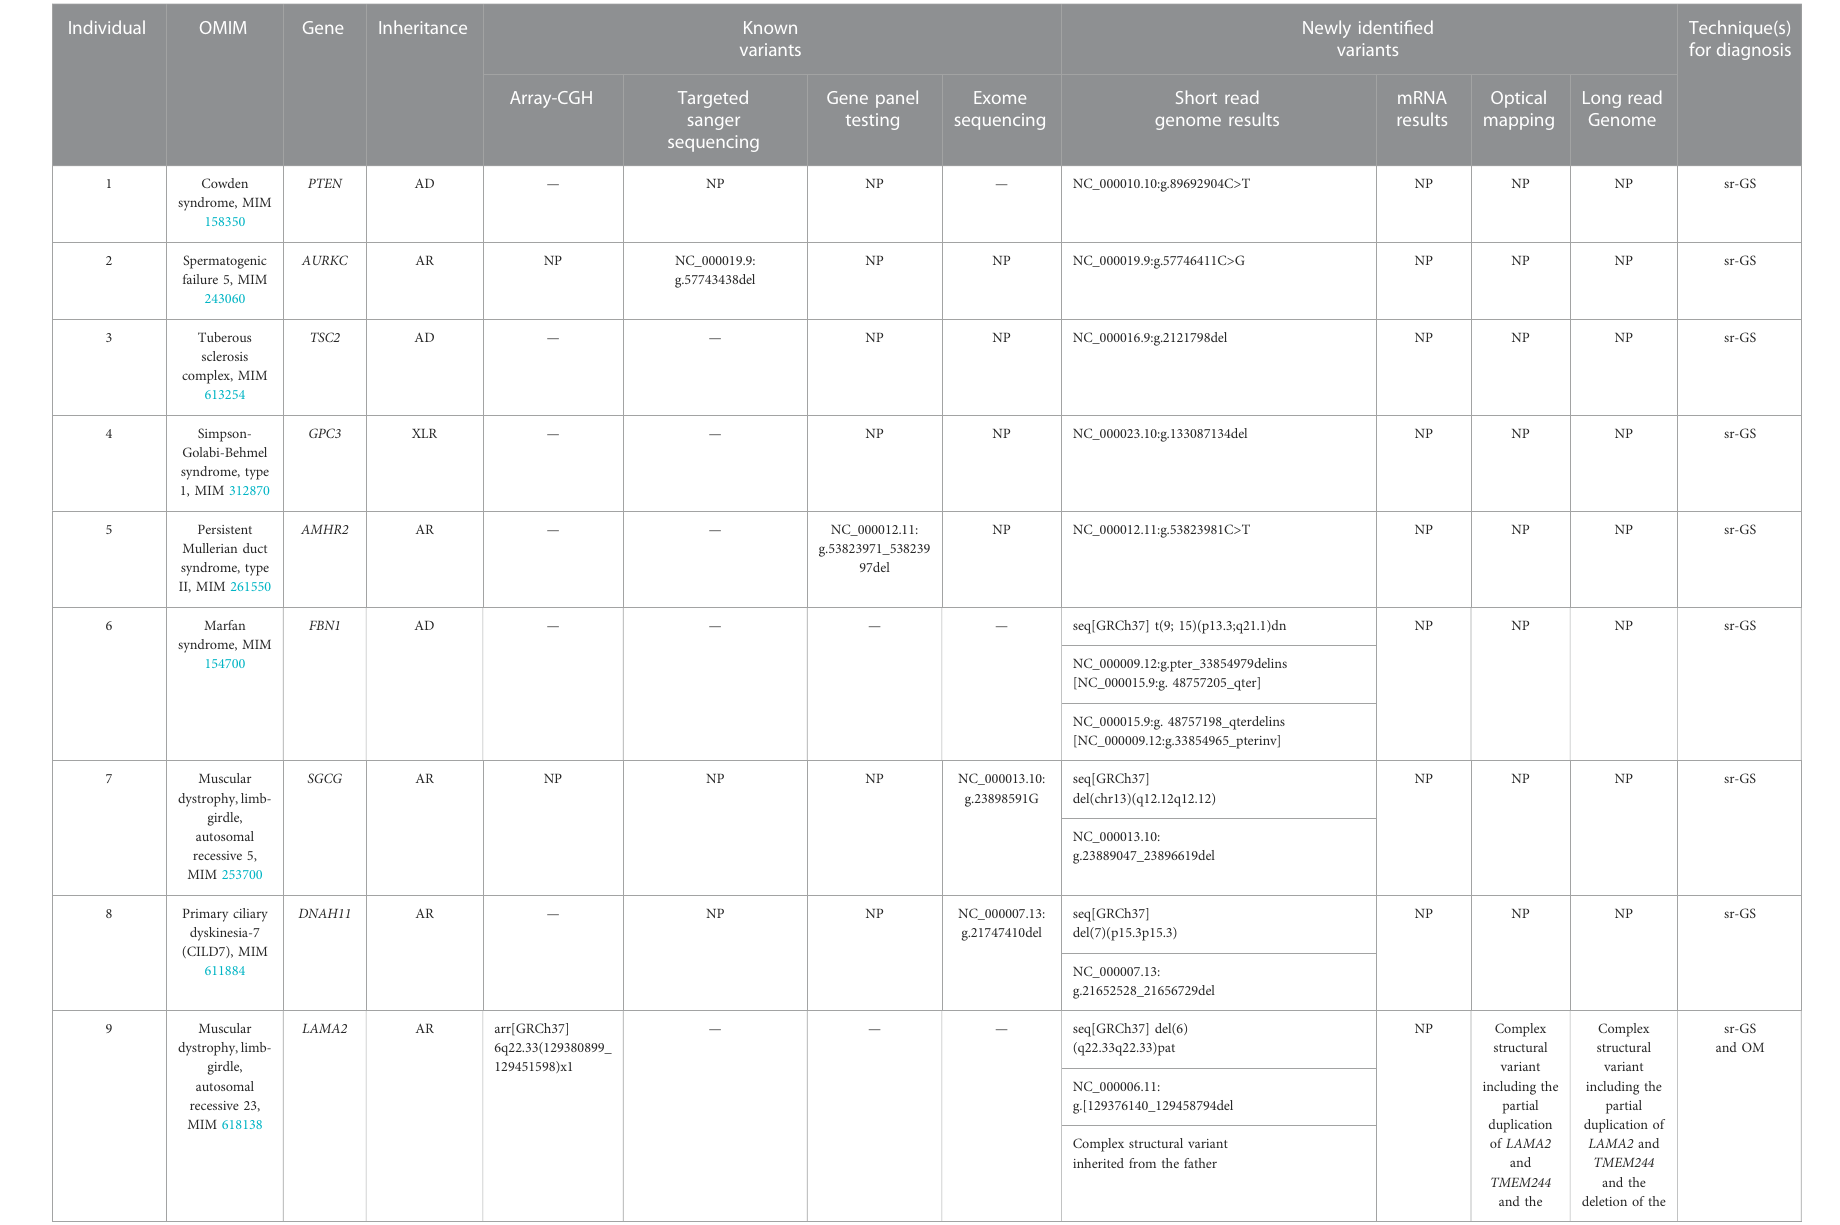
TABLE 1 Cohort of 15 individuals with the different omic tests performed and their outcome. AD, autosomal dominant; AR, autosomal recessive; XLR, X-linked recessive; NP, not performed; sr-GS, short read genome sequencing; mRNA-seq, m RNA sequencing; OM, optical mapping; lr-GS, long read genome sequencing.